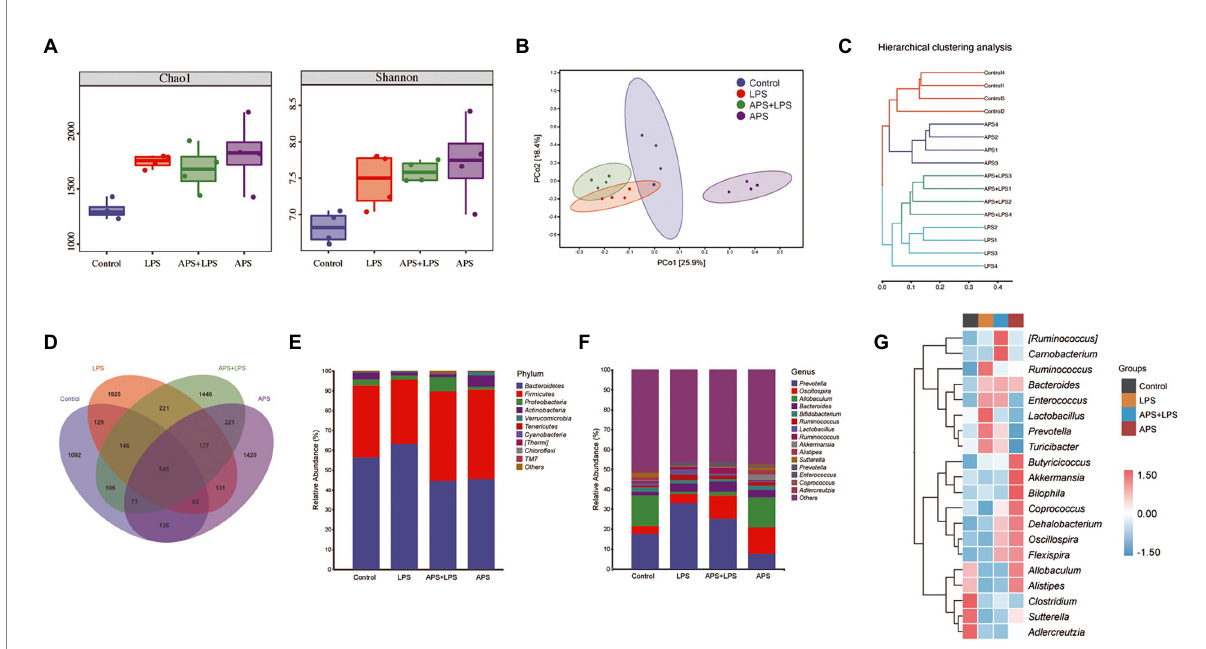
FIGURE 4 APS pre-treatment altered the intestinal microbiota composition. (A) Chao1 indices and Shannon indices of microbiota in colon with n = 4 samples per group. (B) Principal coordinate analysis (PCoA) represented the β -diversity of microbiota composition with n = 4 samples per group. (C) Cluster tree based on unweighted pair-group method with arithmetic mean (UPGMA) analysis. (D) The Venn diagram showed the overlaps of operational taxonomic units (OTUs). (E) The relative abundance of the top 10 phyla among the groups with n = 4 samples per group. (F) The relative abundance of the top 15 genus among the groups with n = 4 samples per group. (G) Heatmap represented the relative abundance changes of the top 20 genus among groups with n = 4 samples per